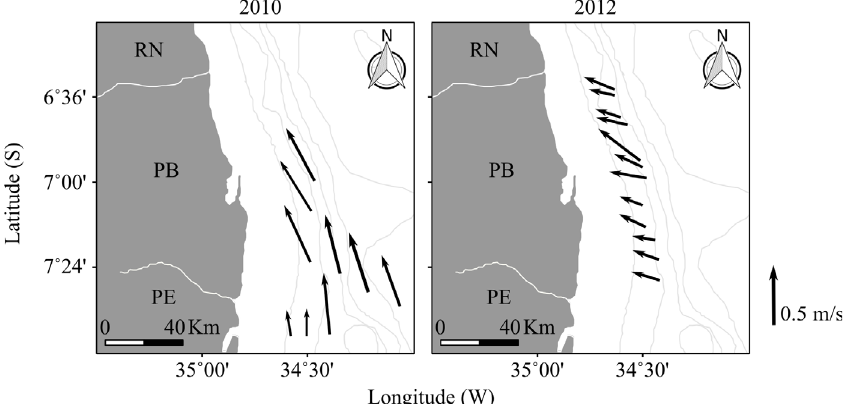
Figure 2. Surface circulation pattern (30 m) in the area between the transects during the sampling periods of 2010 and